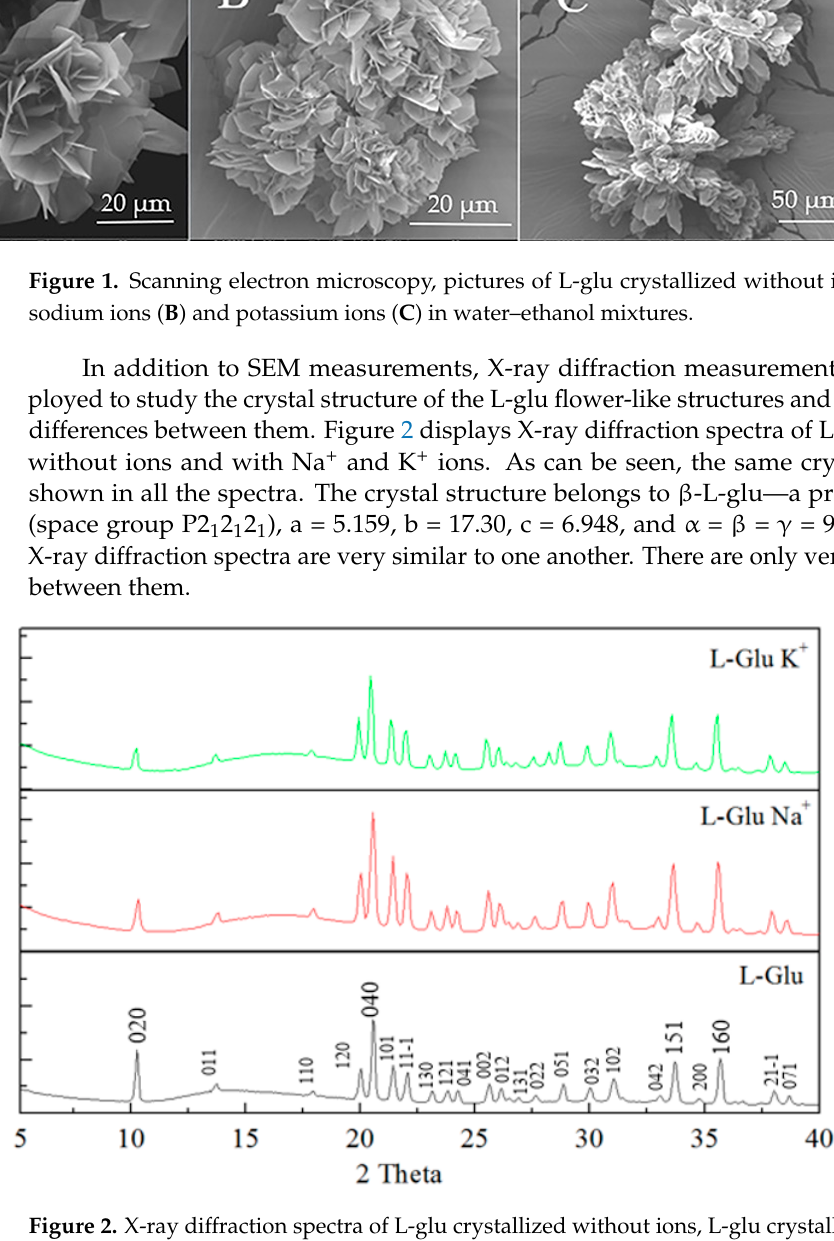
Figure 2. X-ray diffraction spectra of L-glu crystallized without ions, L-glu crystallized with sodium ions and L-glu crystallized with potassium ions.